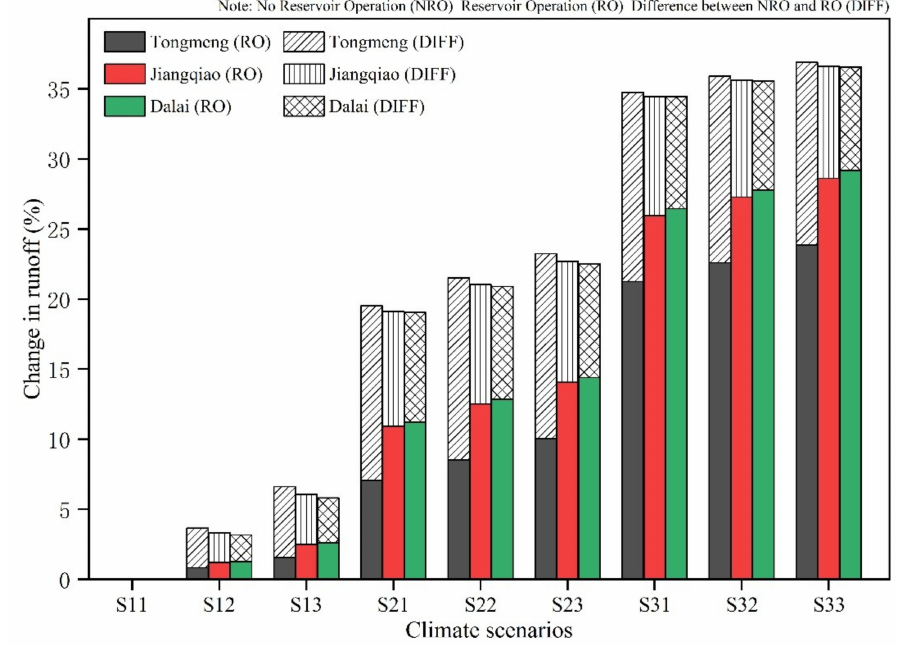
Figure8. Therelativechangerateofmeanannualruno ff simulationresultsfordi ff